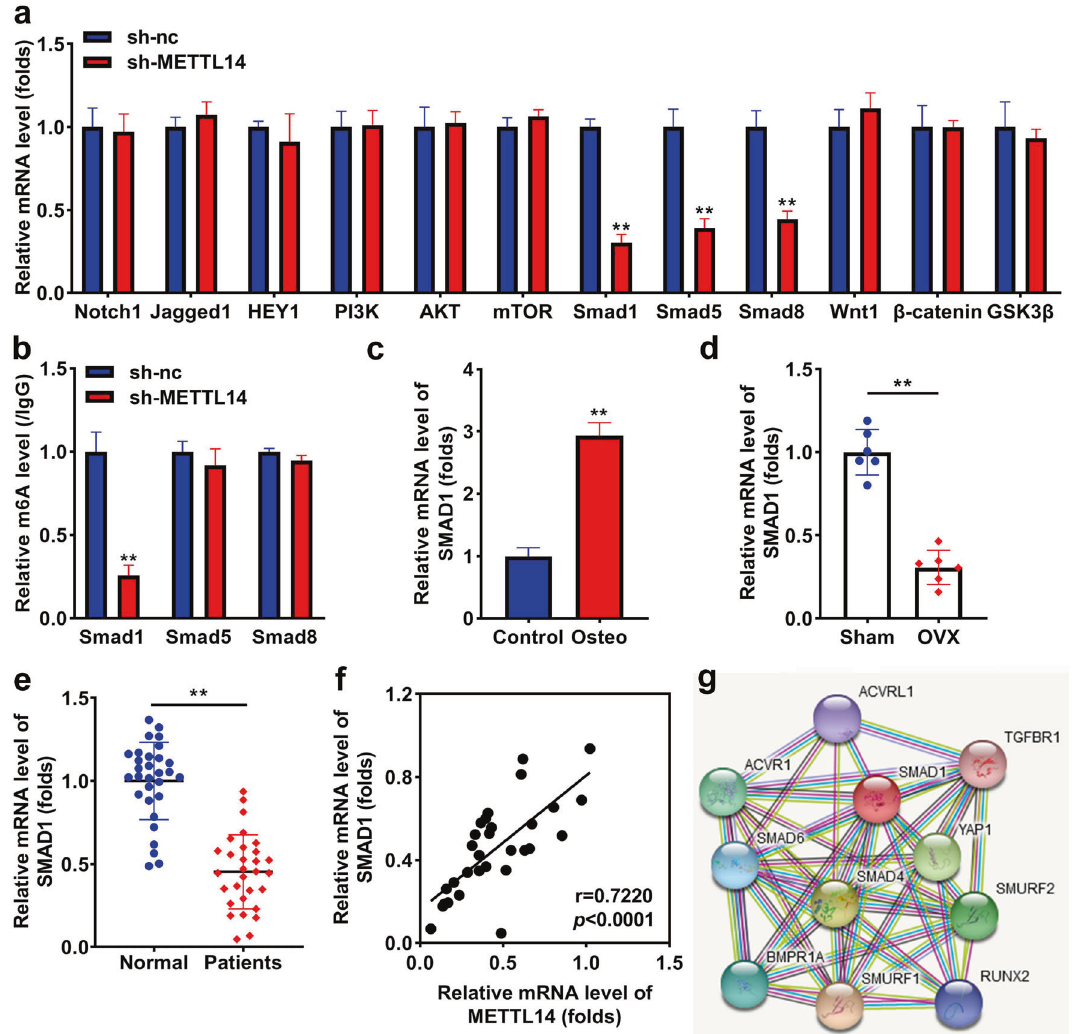
Fig. 5 Knockdown of METTL14 positively regulates SMAD1. a The mRNA levels of Notch1, Jagged1, HEY1, PI3K, AKT, mTOR, SMAD1, Smad5, Smad8, Wnt1, β -catenin, and GSK3 β after transfection with METTL14. b m6A modi fi cation of Smad1, Smad5, and Smad8 following sh-METTL14 transfection. c SMAD1 expression in osteogenic differentiated and undifferentiated BSMCs. d SMAD1 expression in sham and OVX mice. e SMAD1 expression in patients with or without OP (both n = 30). f The relationship between METTL14 and SMAD1 was assessed by Pearson correlation coef fi cient ( g ) SMAD1 related proteins were predicted using the STRING online tool. ** P <